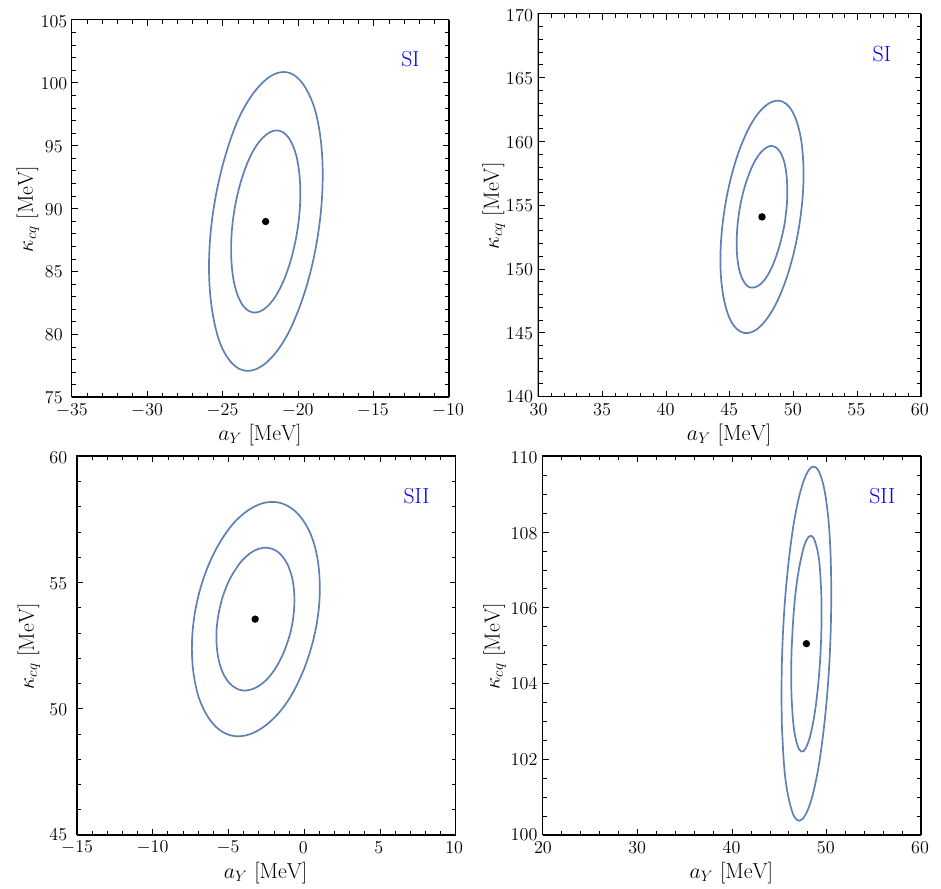
Fig. 2 1 σ - and 2 σ -contours in the a Y − κ cq parameter plane corre- sponding to 68.3 and 95.4% C.L. for scenario I (SI) in the top two frames and scenario II (SII) in the bottom two frames. The dot in each